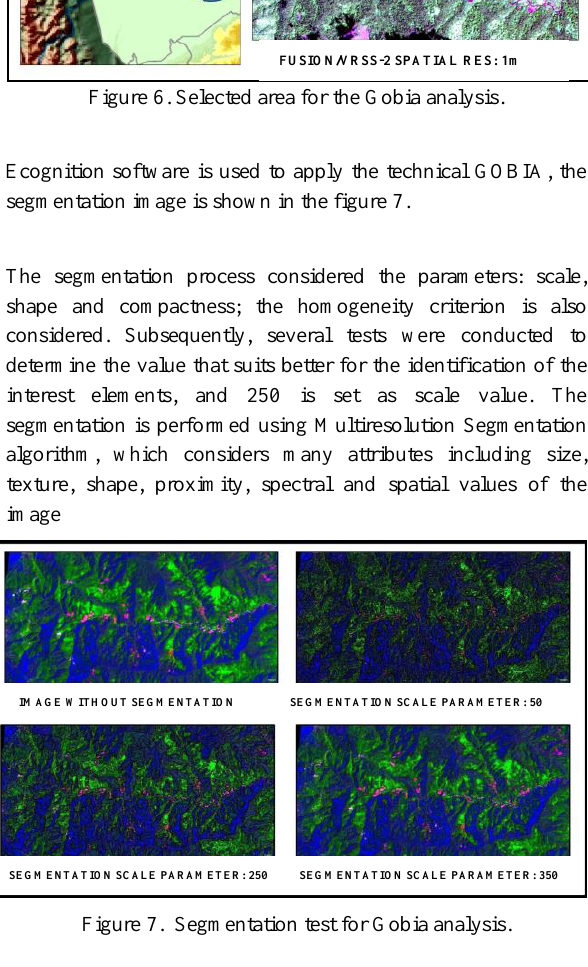
Figure 9. Left to right: slope of the terrain; Proximity to the Colombo-Venezuelan border and proximity to the water